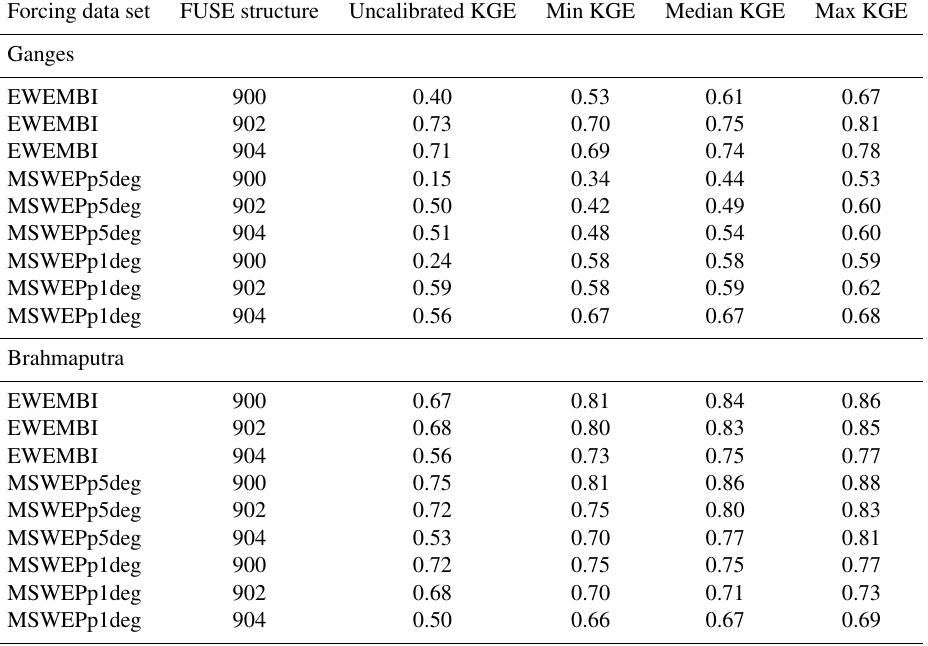
Table 3. Kling–Gupta efficiency (KGE) scores for mizuRoute simulations, categorized by input precipitation data set and FUSE structure. KGE scores are given for simulations with default parameters (uncalibrated) and then minimum, median, and maximum KGE scores from simulations with different calibrated parameter sets. Note that KGE scores are calculated over the rainy season (April–October) between 1985 and